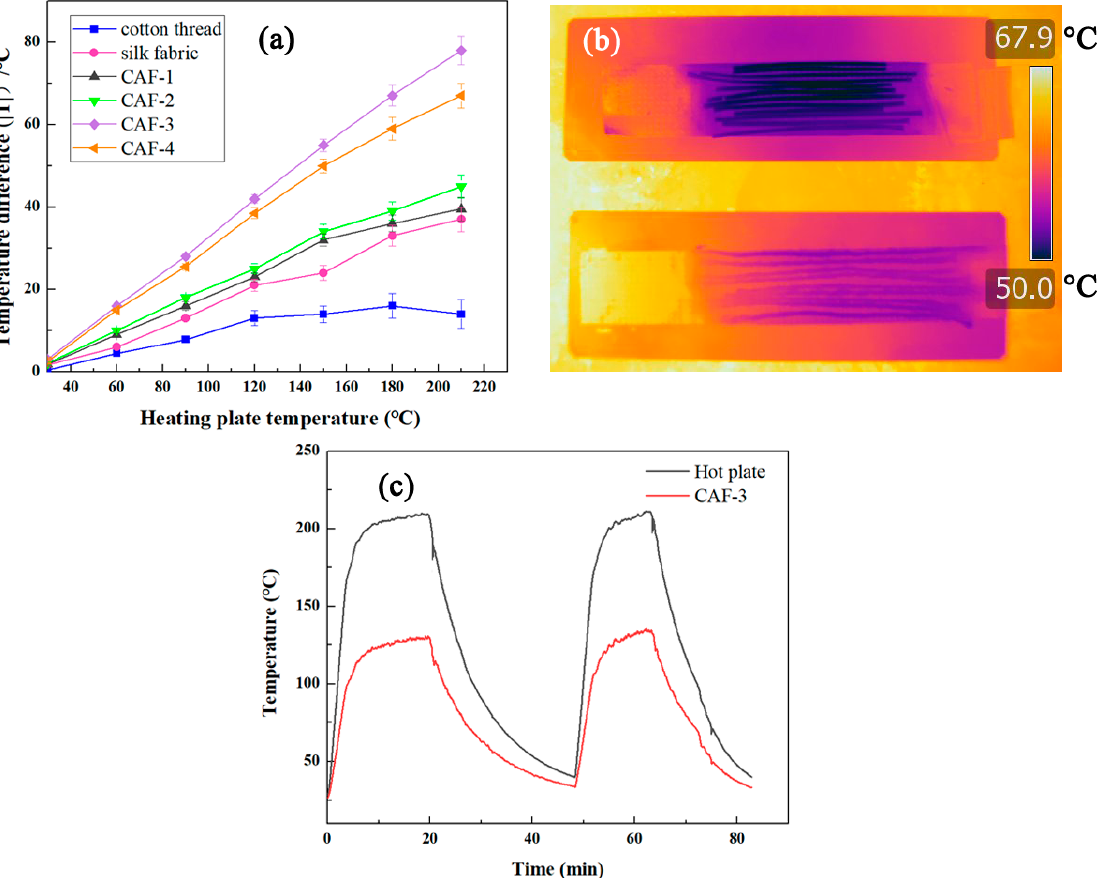
Figure 6. Thermal insulation properties of CAFs, silk fabric, and cotton threads. Temperature difference between the fiber surface and hot plate versus the hot plate for the single-layer mat of CAFs, silk fabric, and cotton threads ( a ). Infrared photo of one-layer mats of CAF-3 and cotton threads at high temperatures ( b ). Temperature–time curves of CAF-3 and hot plate ( c ).